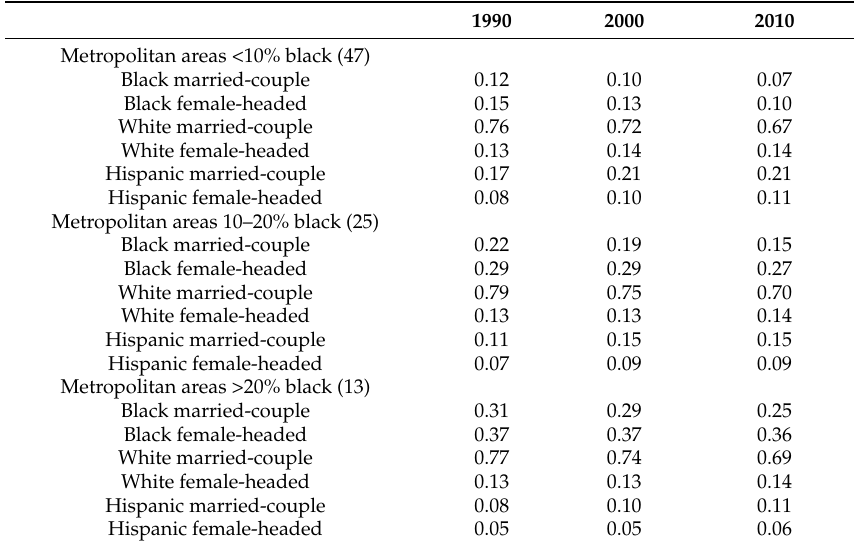
Table 2. Average isolation for 85 metropolitan areas with at least 500 households in each category by percent Black population, using Census 1990–2010 from the NCDB.